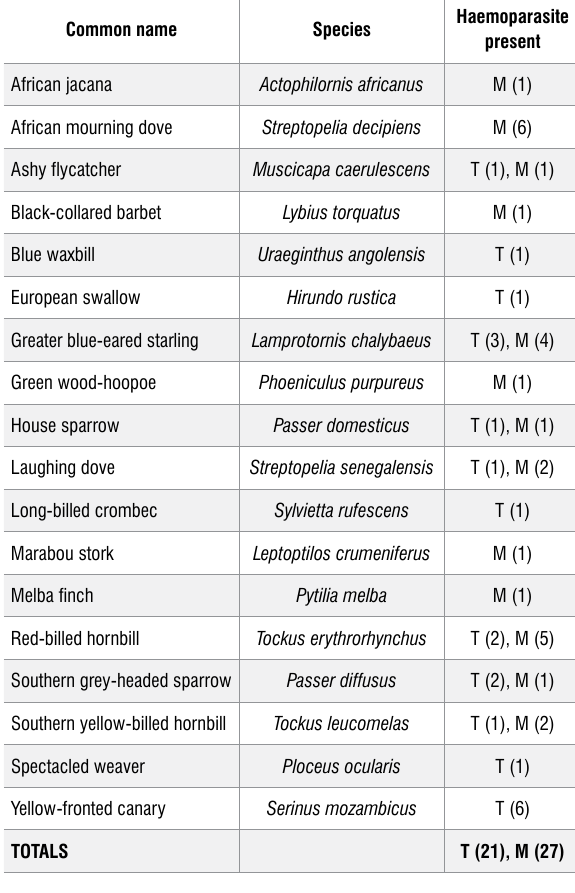
Avian species in which Trypanosoma spp. and microfilariae were detected